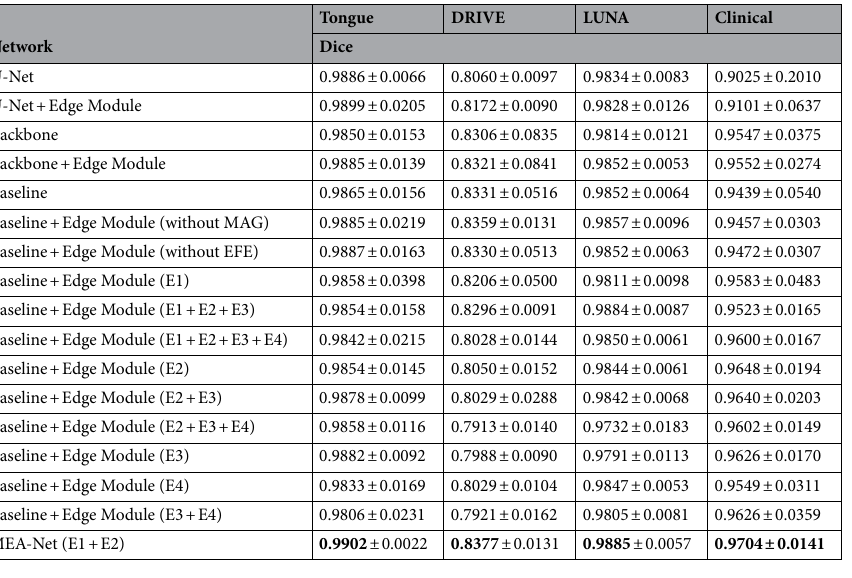
Table 5. Ablation studies for the edge module on four datasets (mean ± standard deviation). Significant values are in